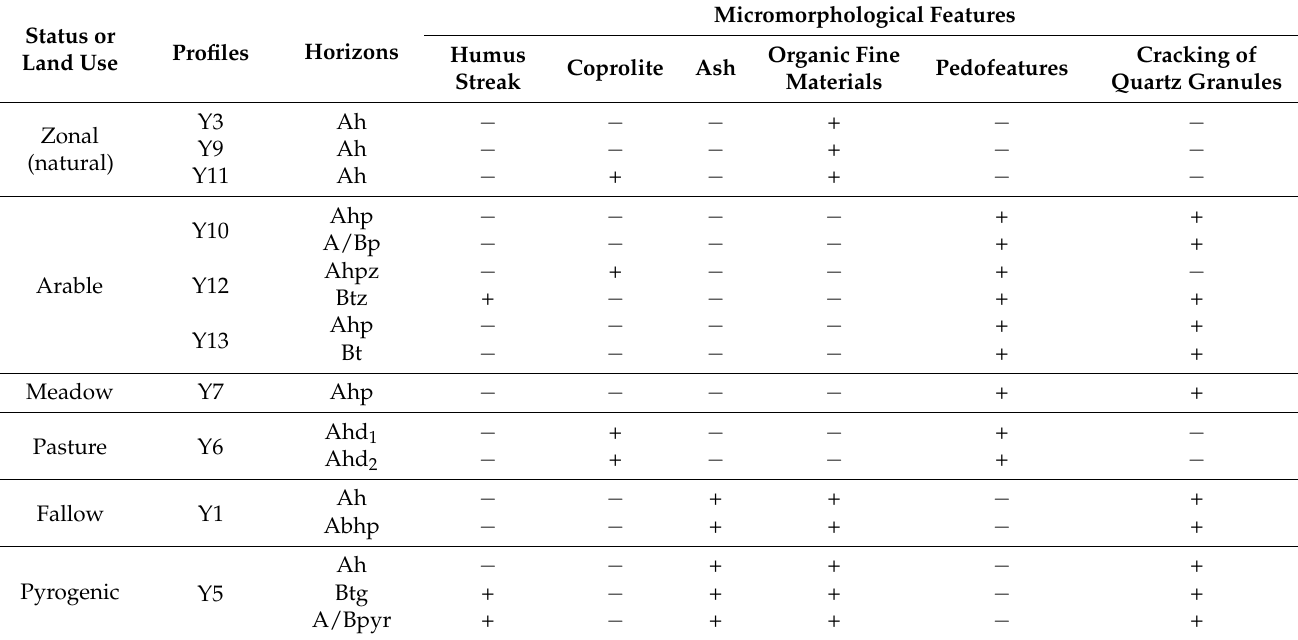
Table 3. The main micromorphological features in studied soil thin